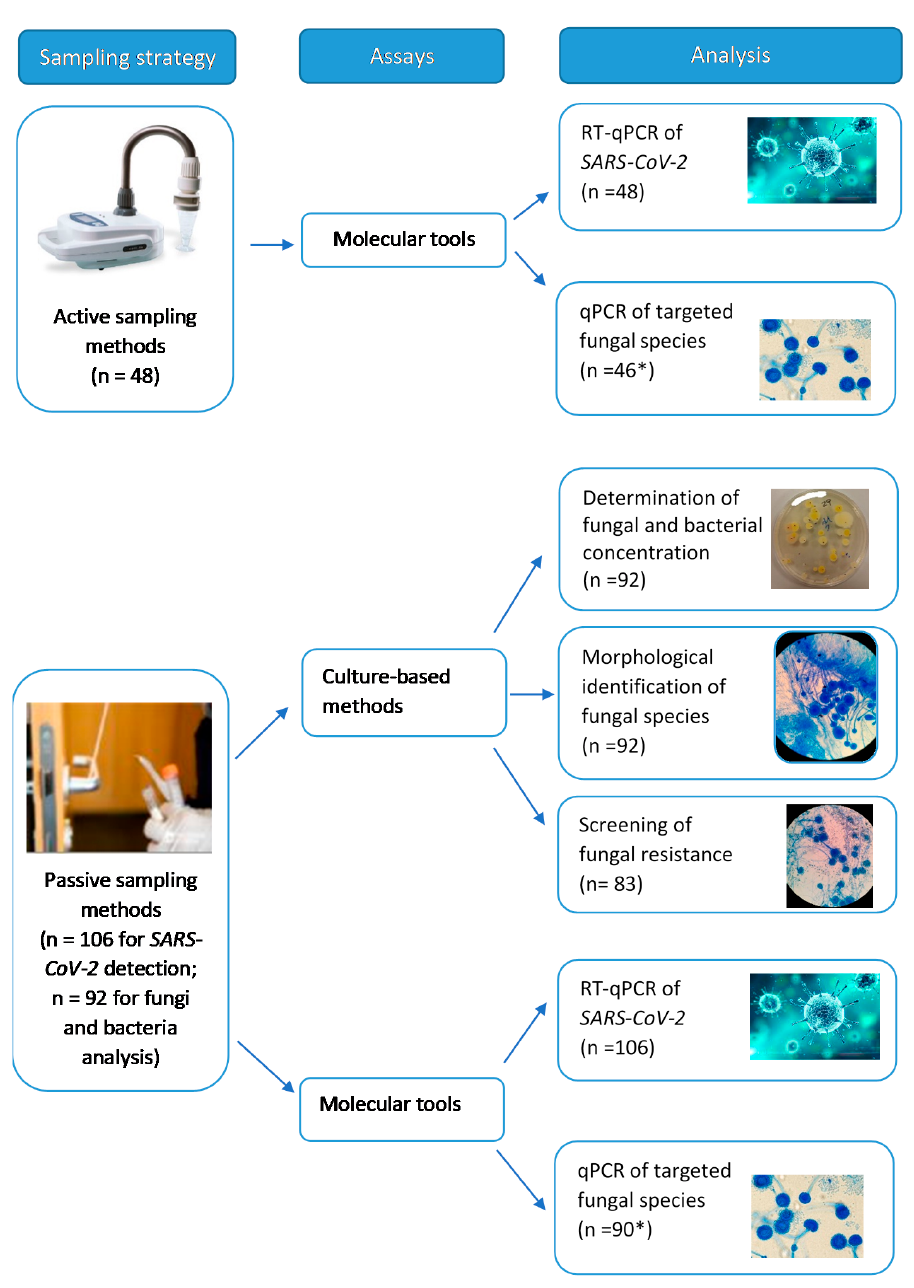
Figure 1. Sampling strategy adopted and assays applied. * Lack of extracts quantities in two samples to perform the assay.